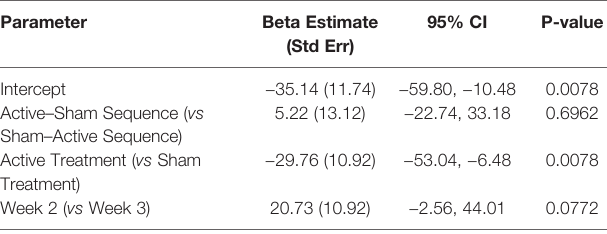
TABLE 5A | Summary of Mixed Model for Percent Change in Mean OCS.